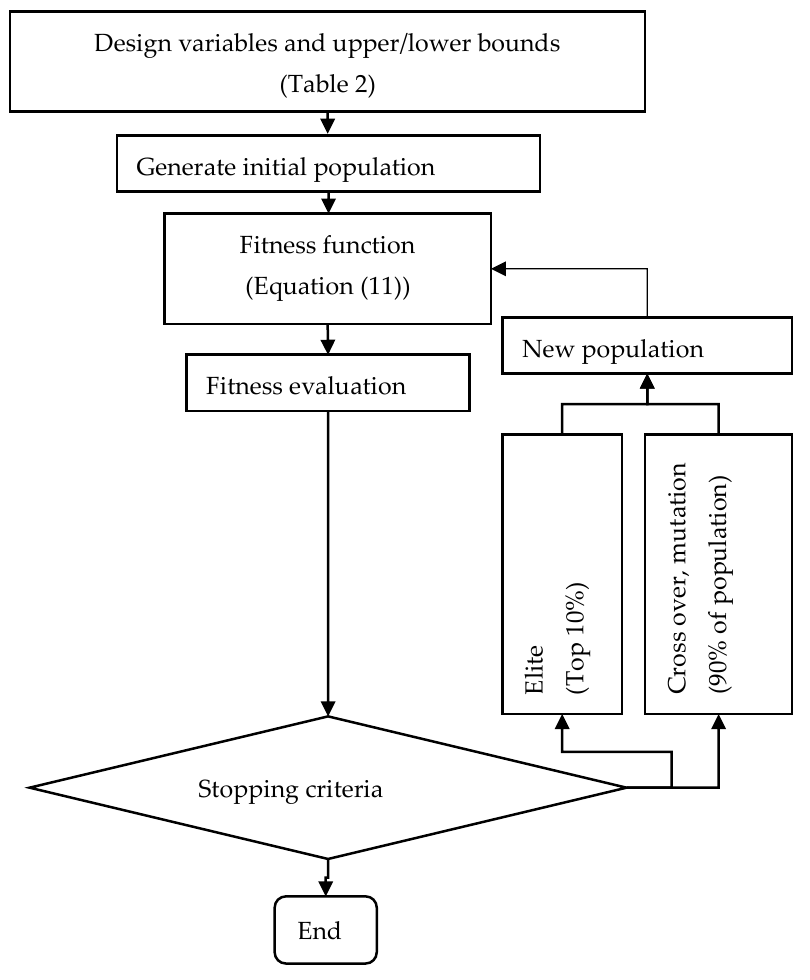
Machines 2021 , 9 , 60 Figure 2. Schematic genetic algorithm. Figure 2. Schematic genetic algorithm. Table 5. Details for inlet and outlet parameters.